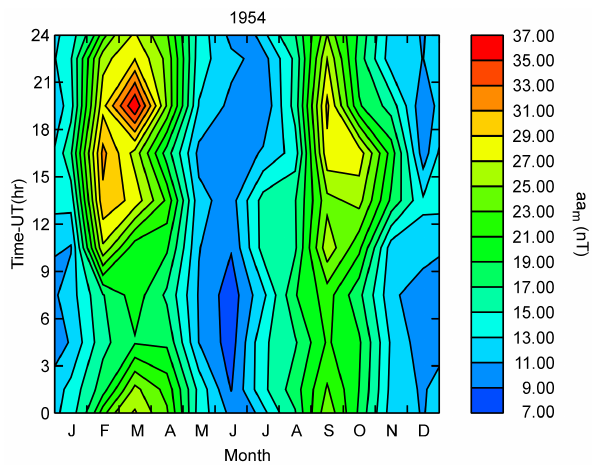
Fig. 7. Diurnal/seasonal variation of the aa m index during